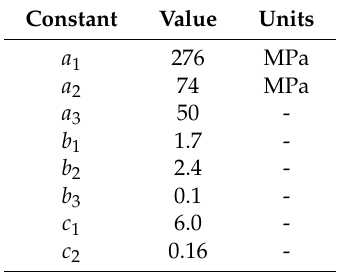
Table 5. FKS material model constants.